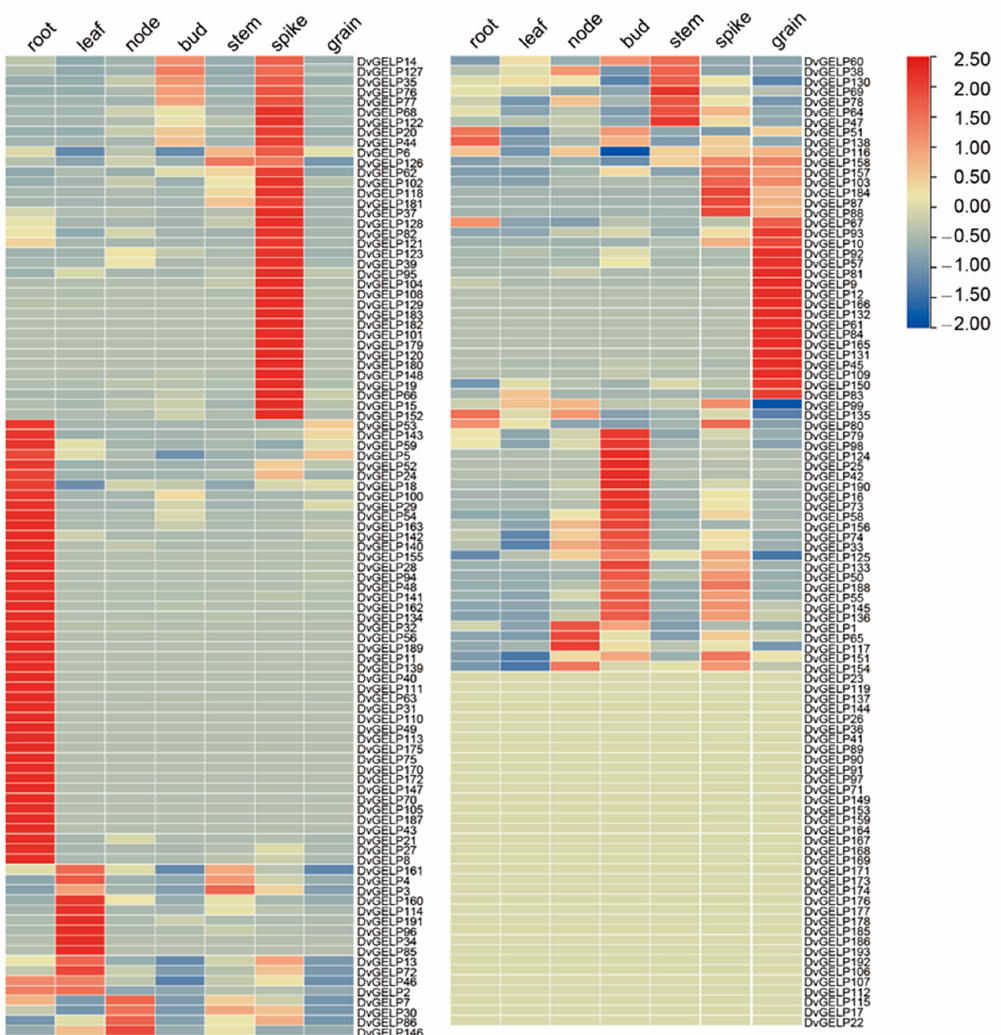
Figure 4. Heatmap of the expression profiling of D. villosum GELPs in different tissues. The expression signal of each gene was based on the Z-score normalization value from the RNA-seq data. The root, leaf, node, bud, stem and spike were sampled at 20 d after flowering, and the grain was sampled at the maturity stage of D. villosum . Each sample has three biological replicates. RNA-Seq was performed using a BGISEQ-500 sequencing platform by BGI Company, Shenzhen, China.